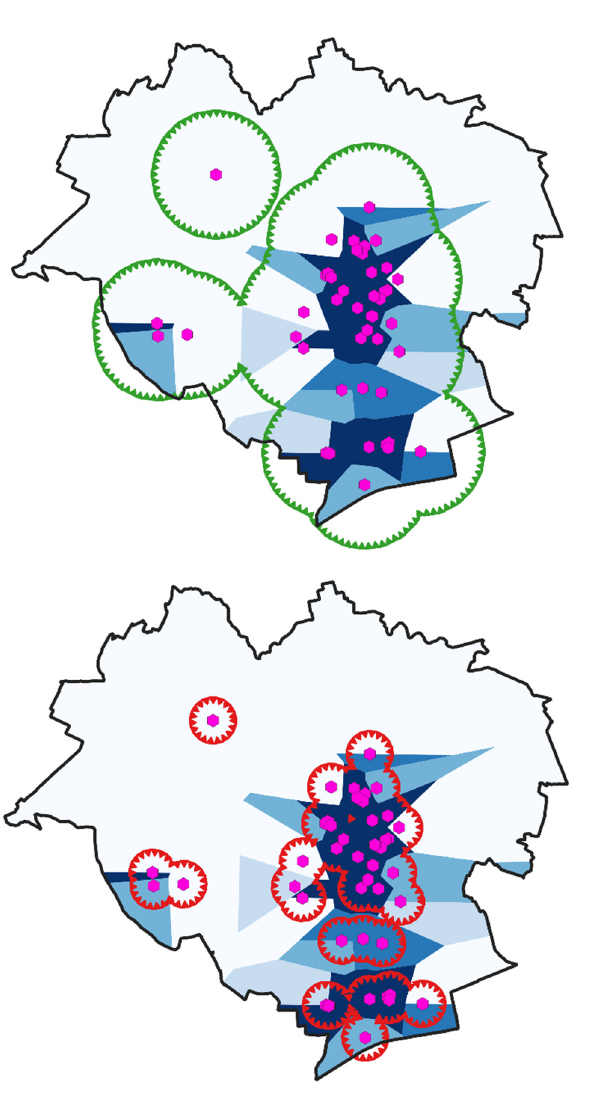
Figure 9. Apparent social dynamics of seniors’ activity on the example of pharmacies. Source: own elaboration.